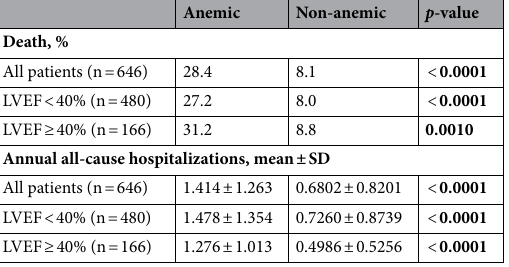
Table 1. Death rate and hospitalization comparisons between anemic and non-anemic patients in the study cohort. LVEF left ventricular ejection fraction. Significant values are in bold.